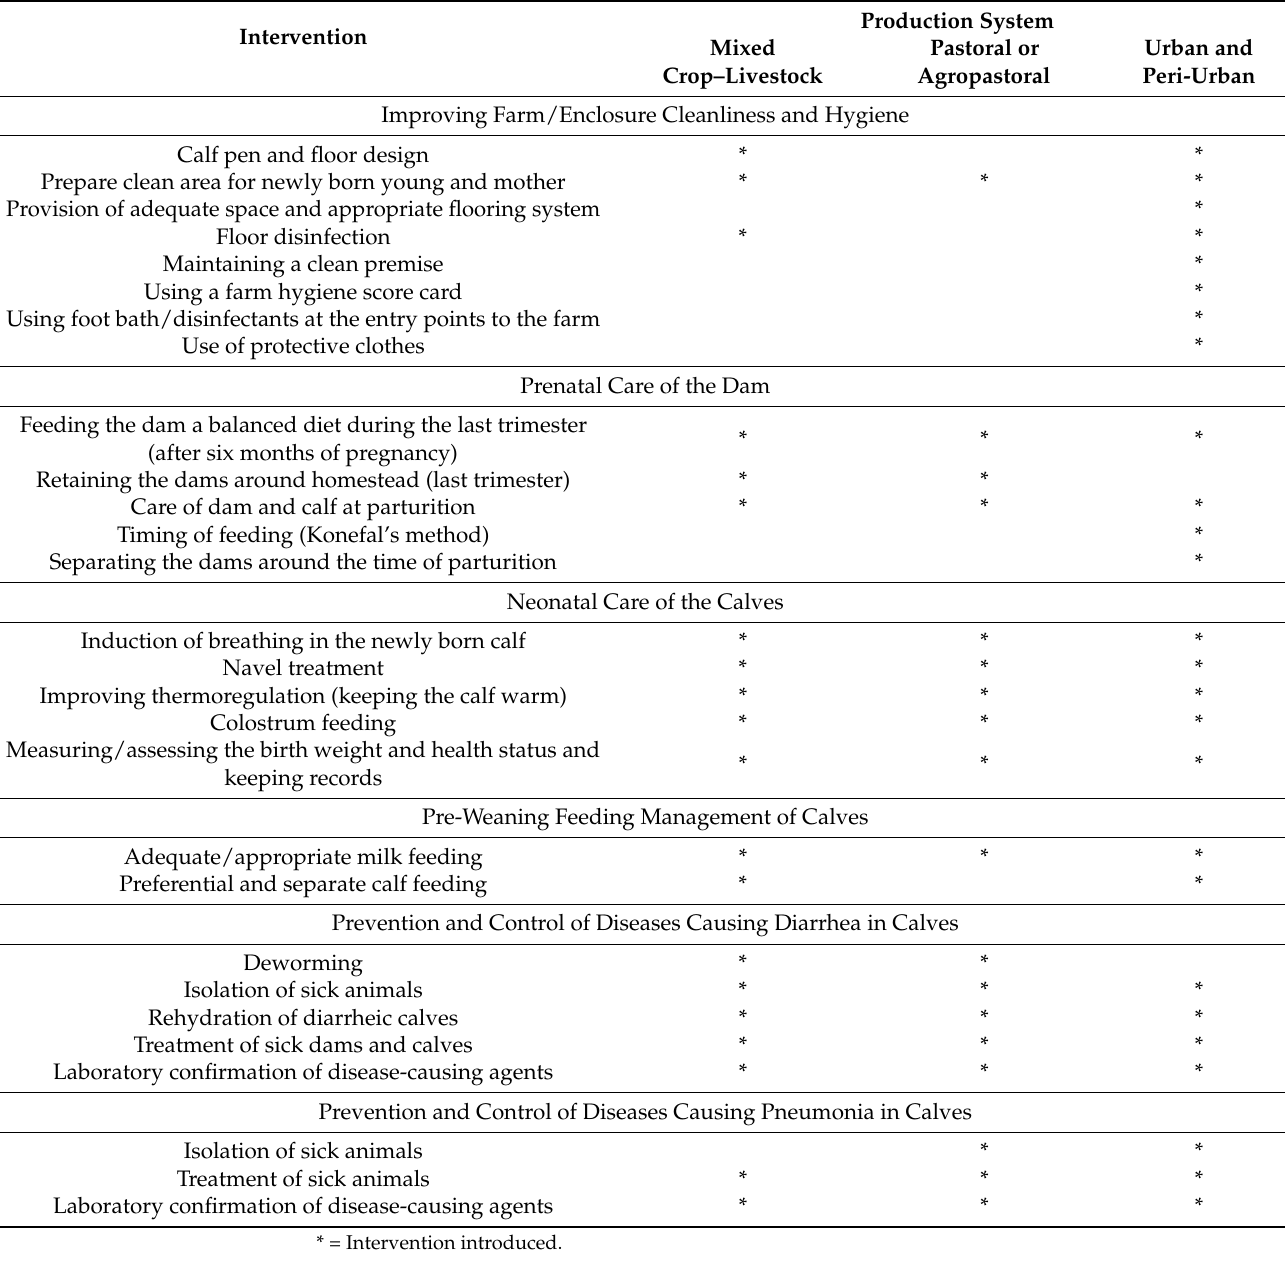
Table A1. Intervention activities included in the intervention arm for each production system. Intervention